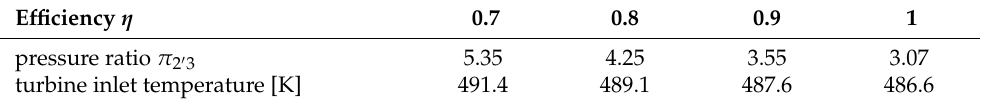
Figure 5. Case 1, Table 1, single expansion for different turbine efficiencies η = [ 0.7,0.8,0.9,1 ] . Table 2. Test case 1 (from Table 1), necessary turbine expansion ratio as a function of turbine